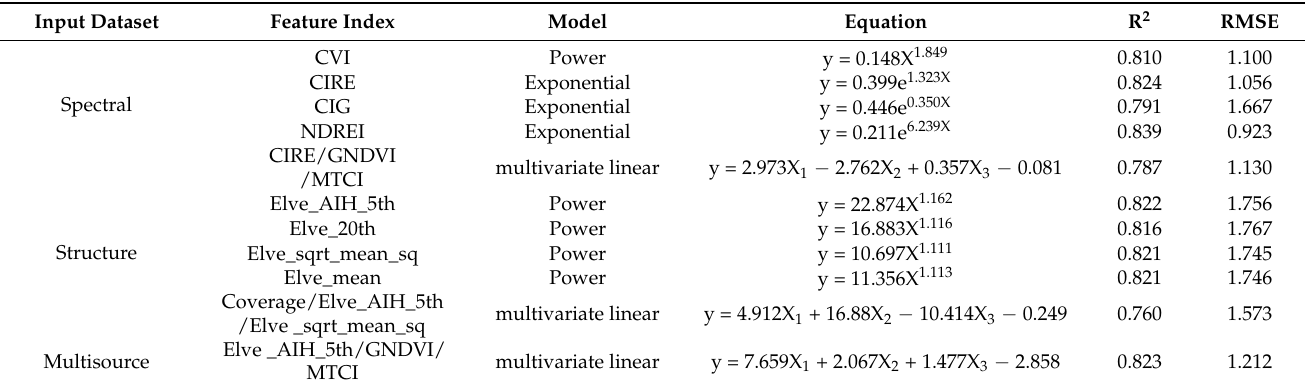
Table 4. Quantitative relationship between the LAI and measured values based on statistical regres- sion models in experiment A.